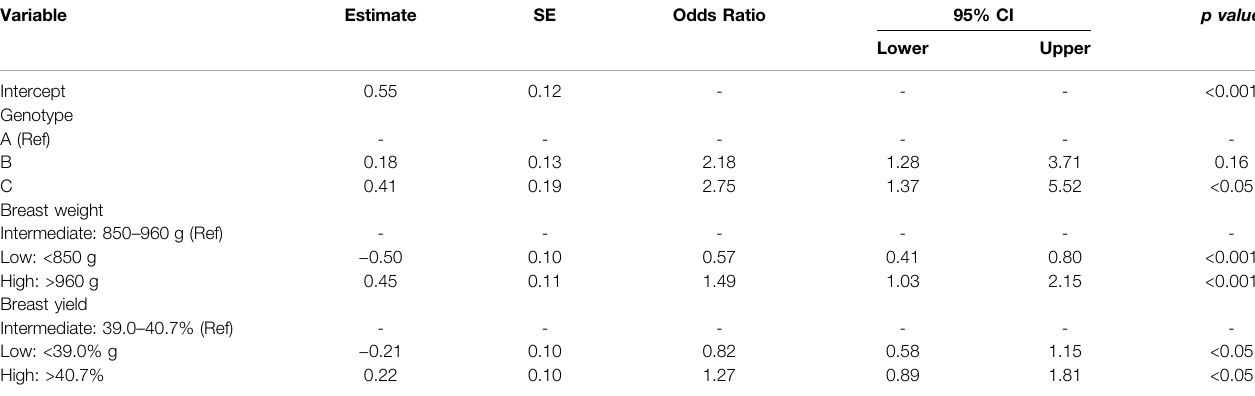
TABLE 4 | Factors in fl uencing white striping occurrence in broiler chickens extracted by forward selection in the multivariate logistic regression analysis. Variable Estimate SE Odds